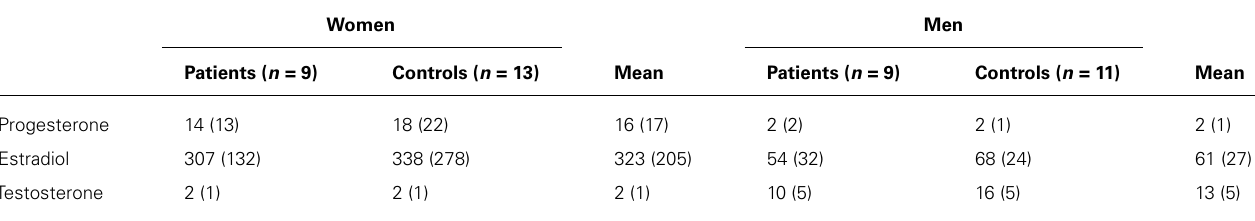
Table 2 | Mean plasma level of gonadal hormones and standard deviations (in parentheses) for each